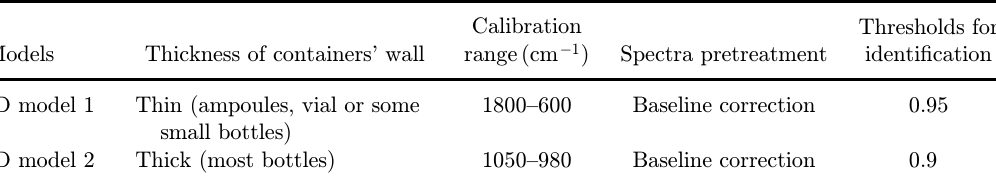
Table 1. Identi¯cation models and relative parameters according to the thickness of containers' wall.